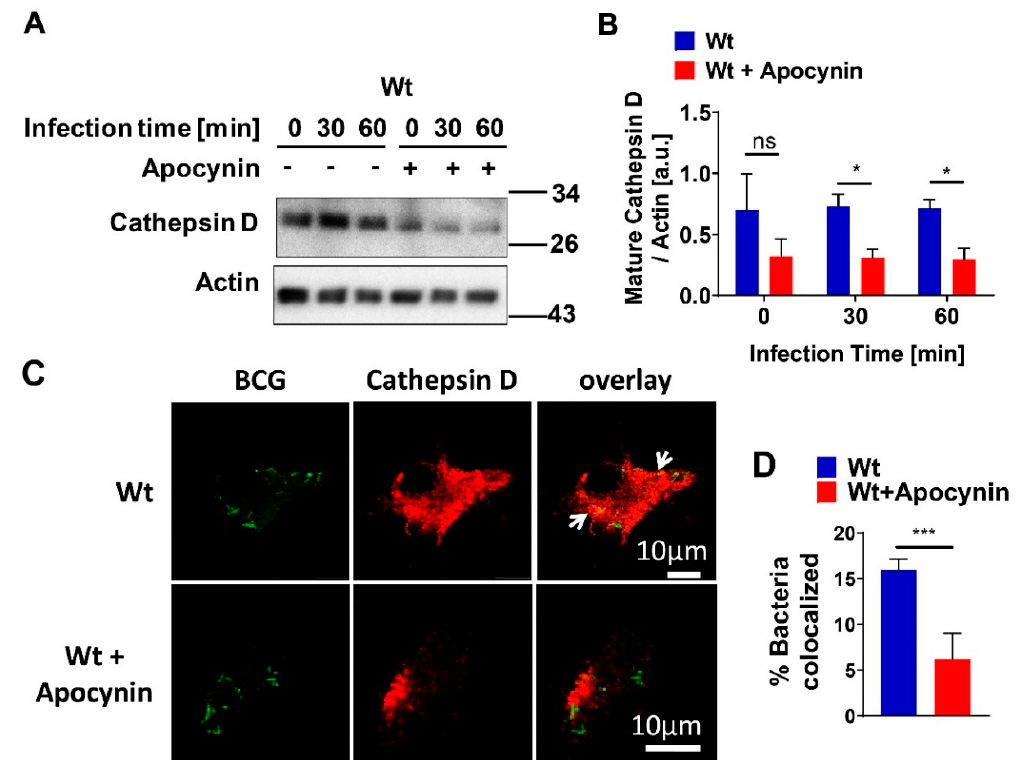
Figure 5. Inhibition of ROS reduces targeting of BCG to cathepsin D. ( A ) Bone-marrow-derived macrophages (BMDMs) from wild-type (wt) mice were left untreated or pretreated with 10 mM apocynin for 1 h, then infected with GFP-BCG for the indicated time or left uninfected and subjected to Western blotting with antibodies against mature cathepsin D (CTSD) / actin. ( B ) Expression of CTSD from wt macrophages was normalized to actin levels and quantification of CTSD arbitrary units (a.u.) was performed using ImageJ. Displayed are means ± SD of 3 experiments; p -values were calculated by ANOVA followed by Bonferroni’s multiple comparisons test. ( C ) Untreated or apocynin treated wt BMDMs were infected for 1 h, fixed, and stained with antibodies against mature CTSD and Cy3-labelled secondary antibodies. Scale bar = 10 µ m. Arrows indicate co-localization of bacteria with CTSD. Shown are representative confocal fluorescence images from at least 3 independent experiments. ( D ) Percentage of GFP-expressing BCG and CTSD co-localization was measured from at least 50 bacteria / sample and presented as mean ± SD of 3 experiments. *** p < 0.001, * p < 0.05 (Student’s t -test). ns = no significant.